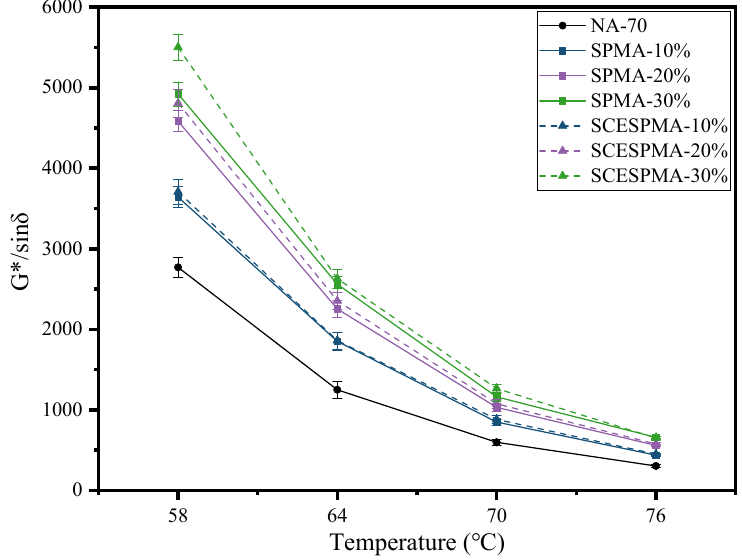
Figure 11. G* and sin δ of SPMA and SCESPMA at different temperatures.